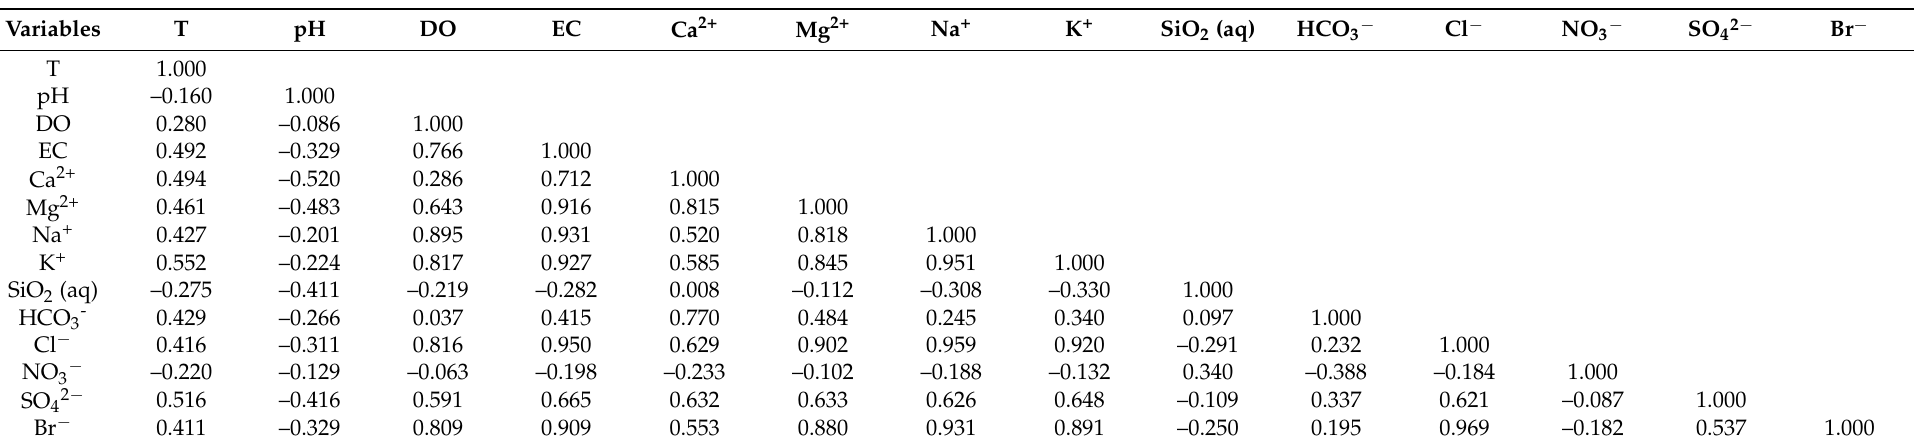
Table 5. Correlation matrix of hydrochemical parameters of groundwater